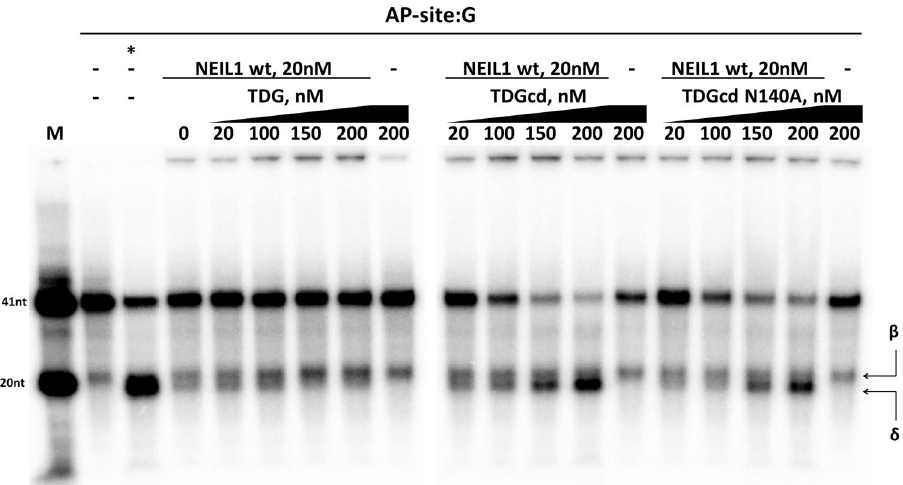
Figure 10. TDGcd or TDGcd N140A stimulate NEIL1 lyase activity: dsDNA containing a 32 P radiolabelled strand with AP-site in position 20 was freshly prepared by excision of a 5caC base in this position using TDG and by subsequent TDG removal using phenol chloroform extraction. NEIL1 (20 nM) was then incubated with the substrate (10 nM) in the presence of different amounts of TDG, TDGcd or TDGcd N140A (37 °C, 30 min). ‘ * ’ represents the AP-site containing dsDNA treated with alkaline conditions (positive control). ‘ β ’ and ‘ δ ’ mark the products of NEIL1 β - and δ -lyase activities,